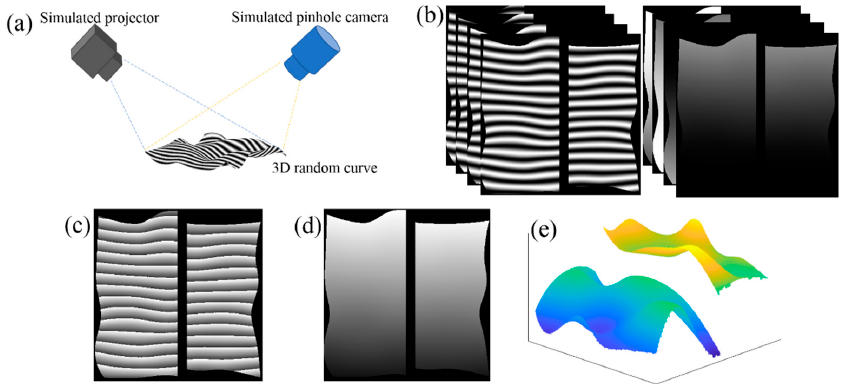
Figure 1. Fringe projection 3D imaging. ( a ) Typical system configuration, ( b ) two sets of isolated surface images modulated by phase-shifted fringes with different pitches, ( c ) wrapped phases, ( d ) unwrapped phases, and ( e ) final unwrapped phase.